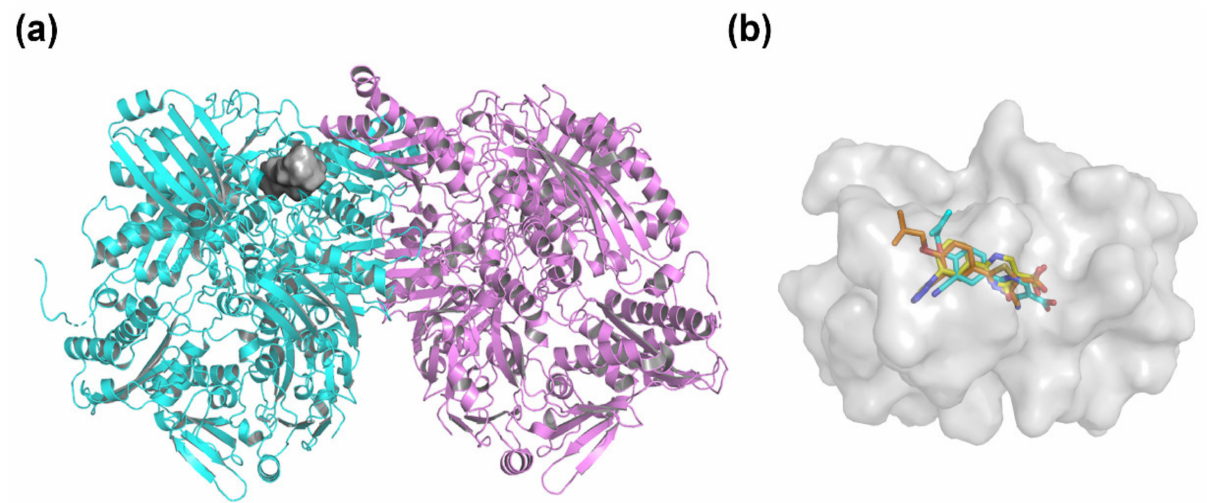
Figure 5. The binding pocket of the XO protein (PDB ID: 1N5X). ( a ) The binding site of the XO protein (chain A, cyan cartoon; chain B, violet cartoon; binding pocket, gray surface). ( b ) The comparisons of febuxostat (orange sticks), compound 44 (cyan sticks), and compound 26 (yellow sticks) in the docking position of the binding pocket (gray